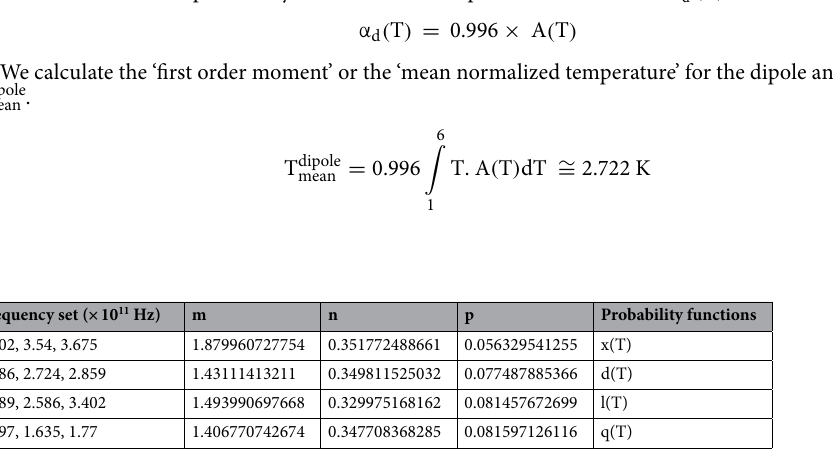
Table 3. Values for various probability functions are given, and they are identified by the notations as x(T), d(T), l(T) and q(T), which correspond to various sets of frequencies.